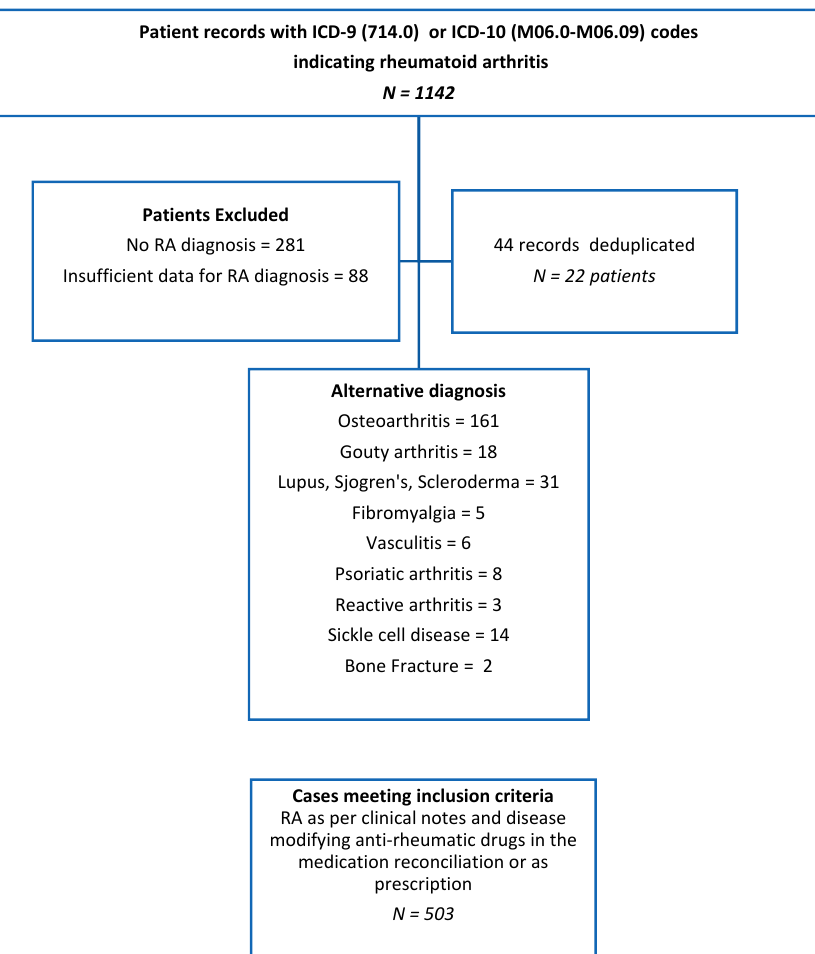
Figure 1. Flow chart delineating the selection procedure of the rheumatoid arthritis cases in the study.ICD-9: International Classification of Diseases, Ninth Revision, Clinical Modification, ICD-10: International Classification of Diseases, Tenth Revision, Clinical Modification.